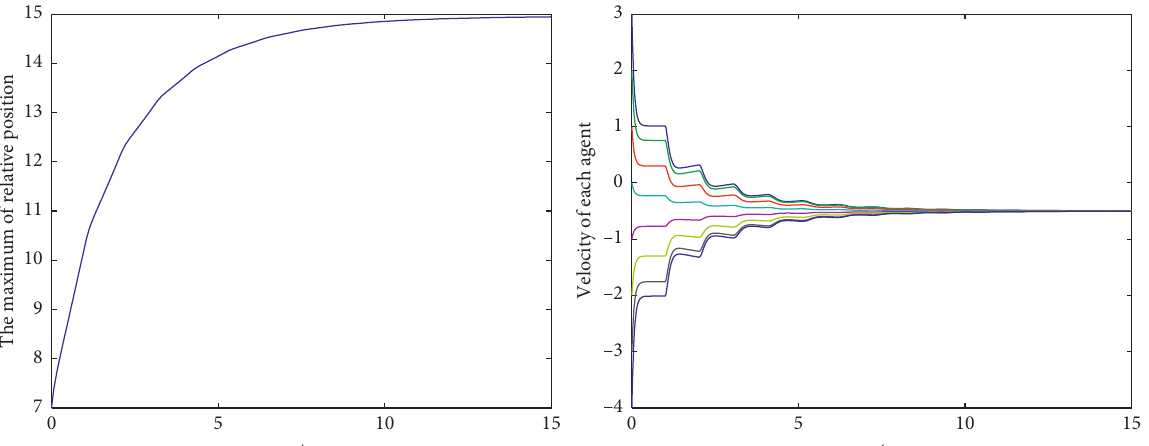
Figure 2: α � 15 , β � 0 . 51 , τ � 1 < τ . Systems (3) and (4) converge asymptotically to form a flock. The convergence rate is slower than that 0 in Example 1 due to processing delays. The diameter of the population is larger than that in Example 1, which means that the cohesion and aggregation density between particles are not as good as the case in Example